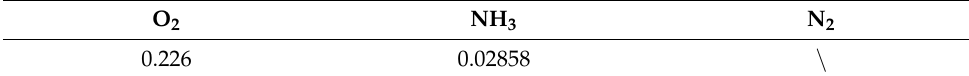
Table 3. Mass fraction of each component at the ammonia injection inlet.